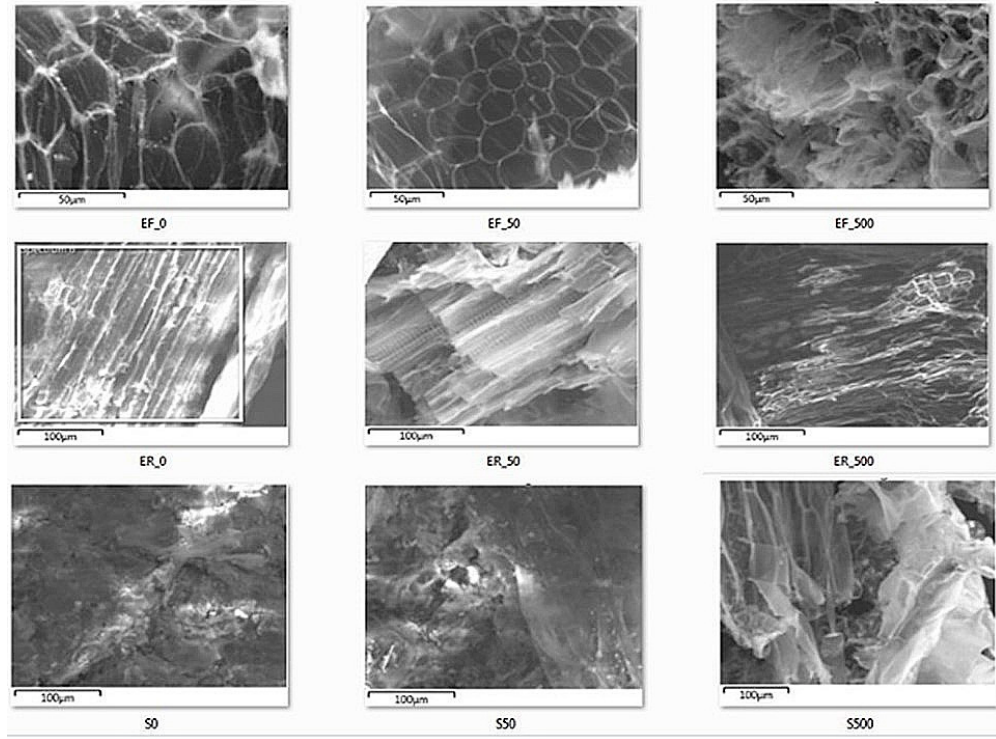
Figure 6. SEM images of E.crassipes and S.natans plants, where EF_0: E.crassipes leaf in control sample, EF_50: E. crassipes leaf in 50 mg / L EBT dye sample, EF_500: E. crassipes leaf in 500 mg / L EBT dye sample, EF_50: E.crassipes leaf in 50 mg/L EBT dye sample, EF_500: E.crassipes leaf in 500 mg/L EBT dye sample, ER_0: E. crassipes root in control sample, ER_50: E. crassipes root in 50 mg / L EBT dye sample, ER_500: E. ER_0: E.crassipes root in control sample, ER_50: E.crassipes root in 50 mg/L EBT dye sample, ER_500: crassipes root in 500 mg / L EBT dye sample, S_0: S. natans leaf in control sample, S_50: S. natans leaf in E.crassipes root in 500 mg/L EBT dye sample, S_0: S.natans leaf in control sample, S_50: S.natans leaf in 50 mg/L EBT dye sample, S_500: S.natans leaf in 500 mg/L EBT dye sample 50 mg / L EBT dye sample, S_500: S. natans leaf in 500 mg / L EBT dye